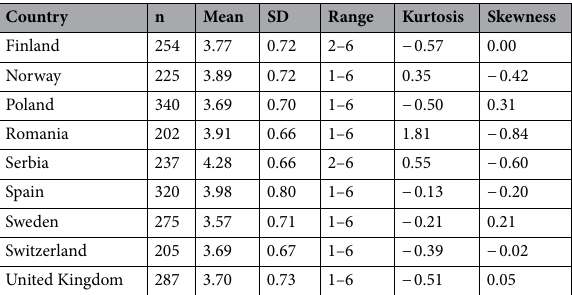
Table 1. Descriptive statistics for overall burnout level and personal values in the study sample of psychotherapists (N = 2915) according to country of origin.